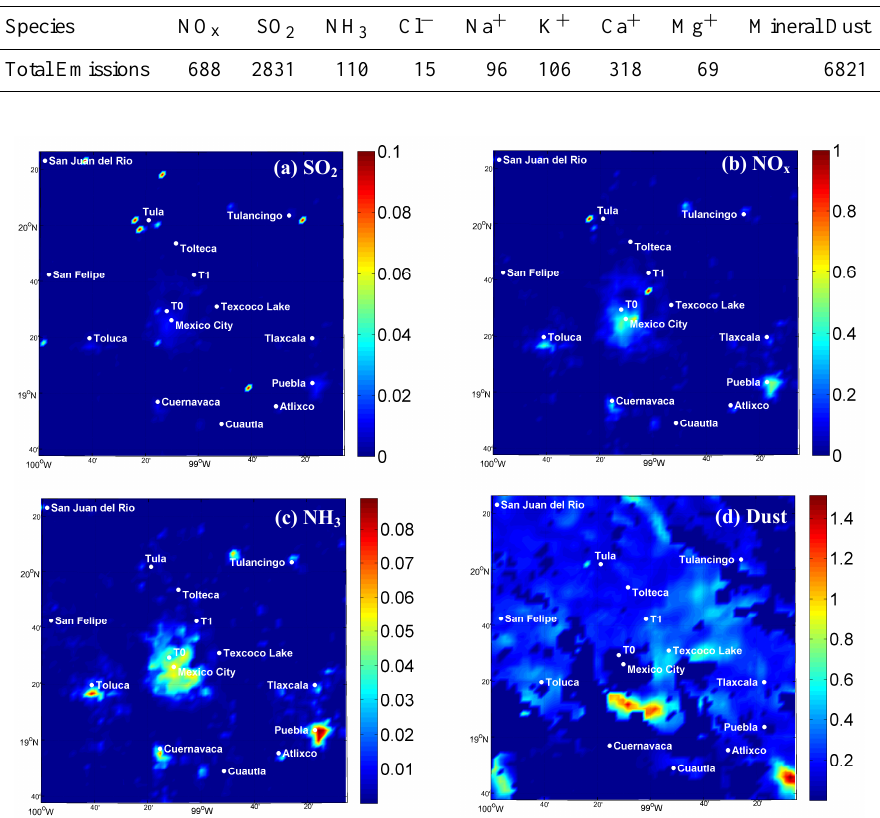
Fig. 2. Spatial distribution of total emissions of (a) SO 2 , (b) NO x , (c) NH 3 , and (d) Dust (tons day − 1 km − 2 ) . SO 2 and NO x emissions from Tula are up to 30 and 2.5tons day − 1 km − 2 , respectively.